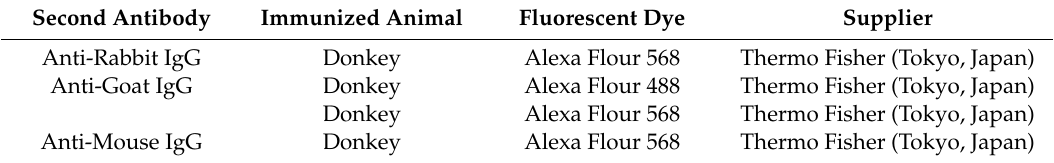
Table 2. Antibodies used in double-fluorescent